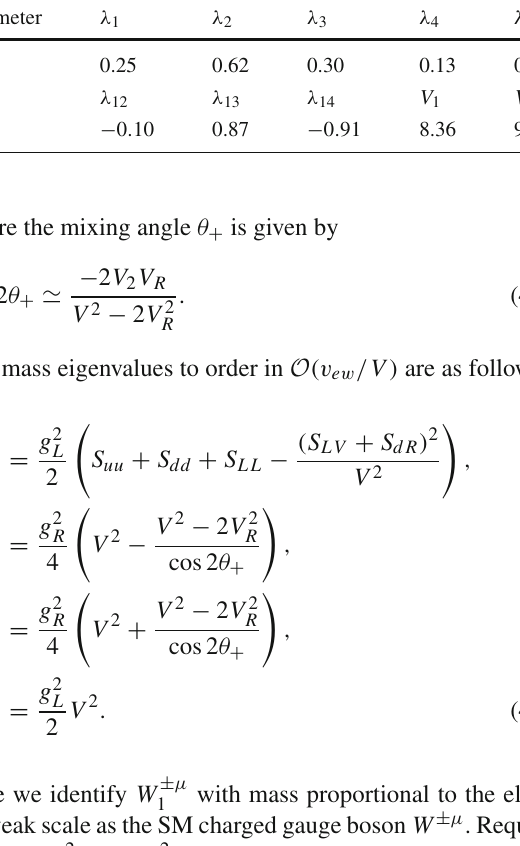
are in the units of TeV. The masses for the Higgs field { h i , h (cid:10) from Eq. (23), Eq. (26), and Eq. (29) are { 17 . 6 , 11 . 6 , 10 . 7 , 5 . 38 , 2 . 71 } , { 29 . 6 , 17 . 5 , 5 . 80 } and 18 . 8 in the units of